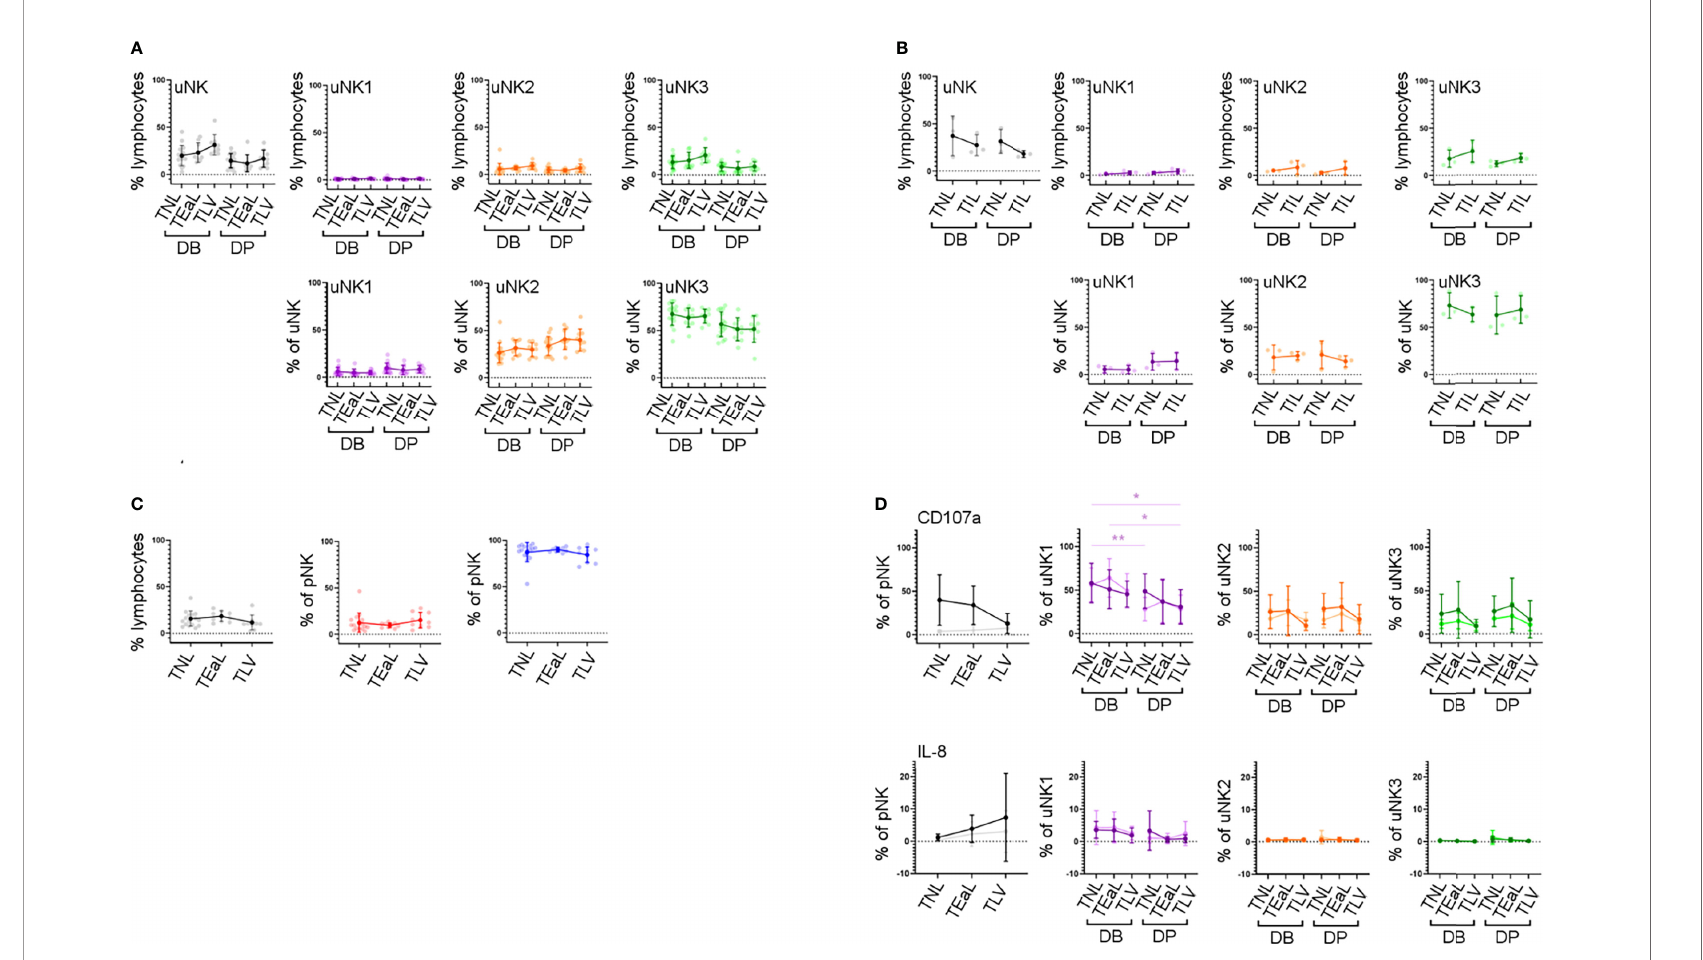
FIGURE 5 | uNK phenotype and function do not change in labour. (A) The FACs gating strategy shown in Figure 2A was used to identify the three uNK subsets. Graphs show frequency of total NK from CD45+ lymphocytes and then frequency of each uNK subset (uNK1, uNK2, and uNK3) as both a proportion of CD45+ lymphocytes and proportion of total uNK cells. Graphs are divided to show results from both decidua basalis and decidua parietalis. Means and SDs are shown for n = 16 (TNL), n = 9 (TEaL), and n = 9 (TLV). Statistical testing was done using Kruskal – Wallis with a post-hoc Dunn test: * p < 0.05, and ** p < 0.01. (B) Using the scRNAseq dataset, graphs show frequency of total NK from CD45+ lymphocytes and then frequency of each uNK subset (uNK1, uNK2, and uNK3) as both a proportion of CD45+ lymphocytes and proportion of total uNK cells. Graphs are divided to show results from both decidua basalis and decidua parietalis. Means and SDs are shown for n = 3 (TNL) and n = 3 (TIL). (C) The FACs gating strategy shown in Figure 2C was used to identify the two pNK subsets. Using fl ow cytometry data, graphs show frequency of total NK from CD45+ lymphocytes and then frequency of each pNK subset (CD56 Bright and CD56 Dim ) from total NK. Sample numbers for each group are the same as in panel (A, D) Uterine and peripheral NK cells were cultured as described in Figure 4A . Graphs showing frequencies of CD107a and IL-8 on pNK and uNK subsets. Unstimulated cells are represented by lighter lines and stimulated cells by darker lines. n, numbers for each group are the same as in panel (A) Statistical testing was done using Kruskal – Wallis with a post-hoc Dunn test: * p < 0.05, and ** p < 0.01. DB, decidua basalis; DP, decidua parietalis; TNL, term non-labouring; TEaL, term early labouring; TLV, term vaginal birth; TIL, term in